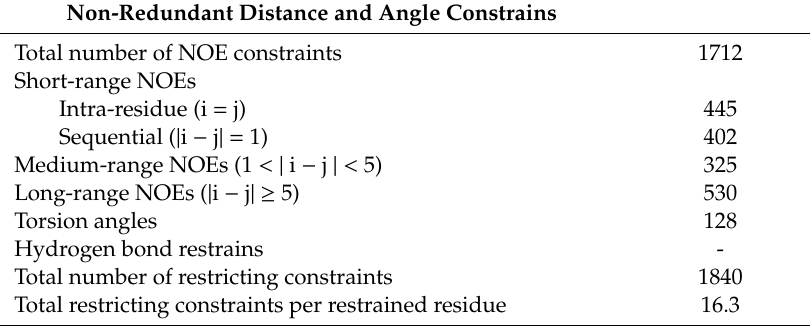
Table 1. Statistics for the final water-refined sets of